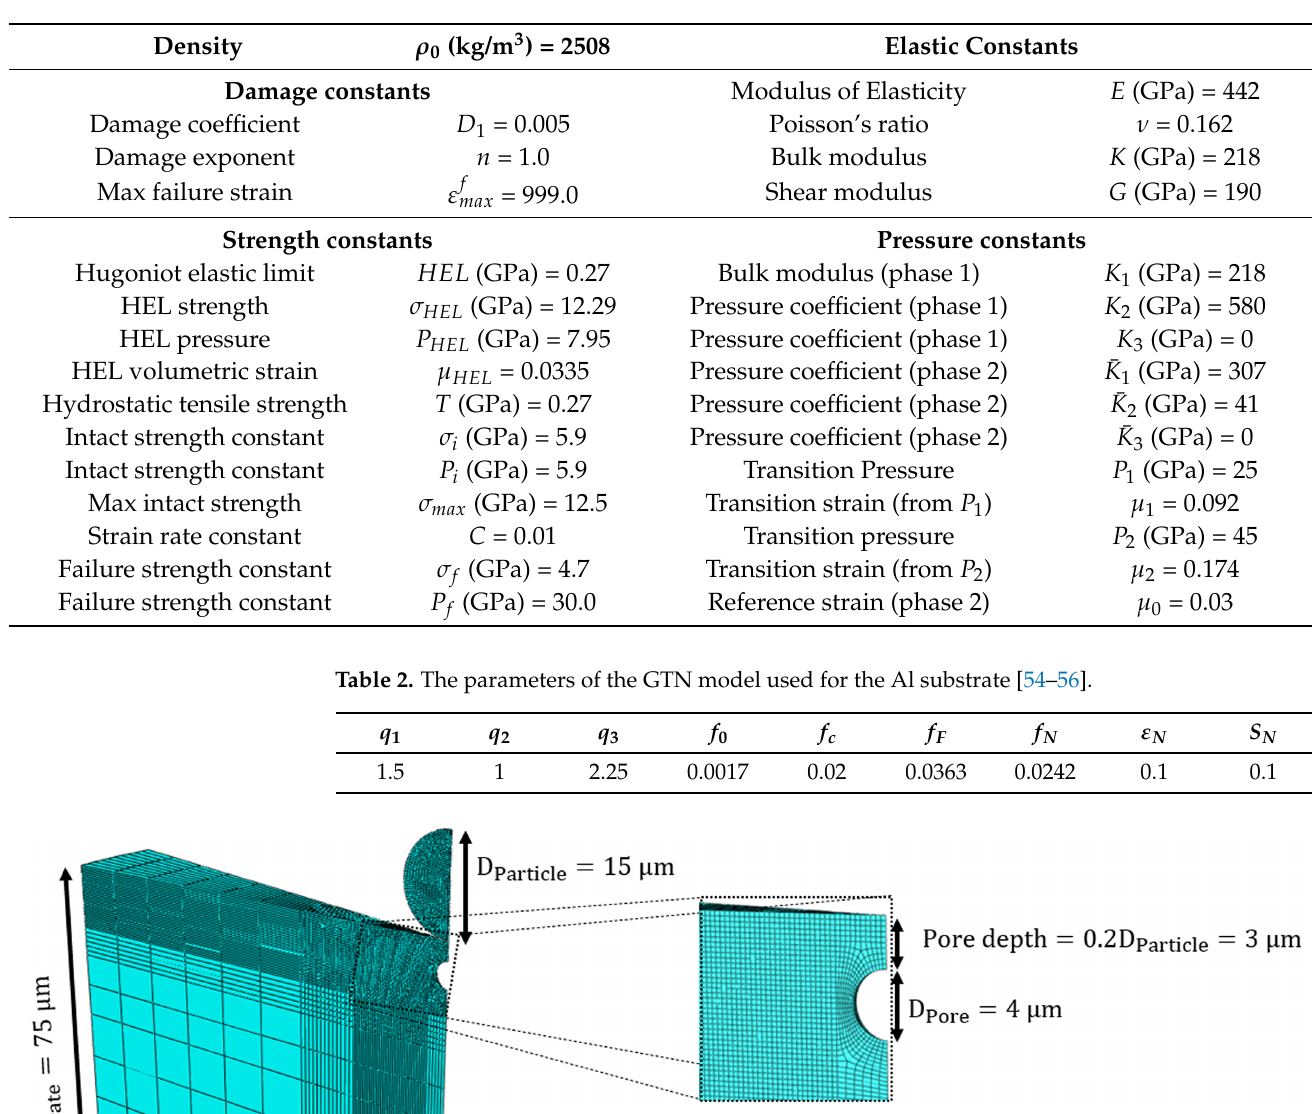
Table 1. The parameters of the JHB constitutive model used for the B 4 C particle [61].